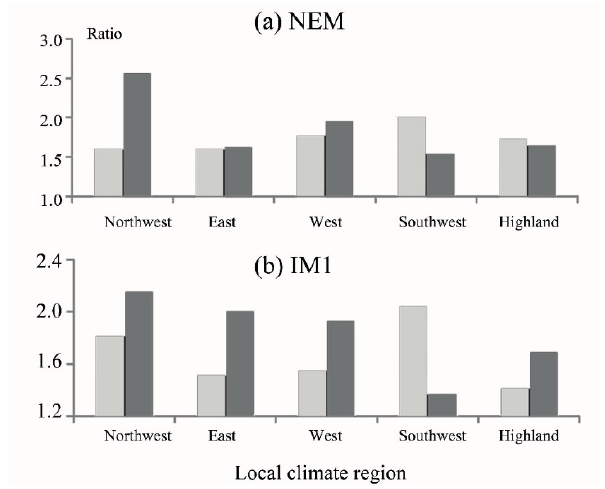
Figure 3. Ratio between 0.25 and 0.125 deg. TRMM-rain gauge validation. ( a ) Northeast monsoon (NEM); ( b ) Inter-monsoon 1 (IM1).